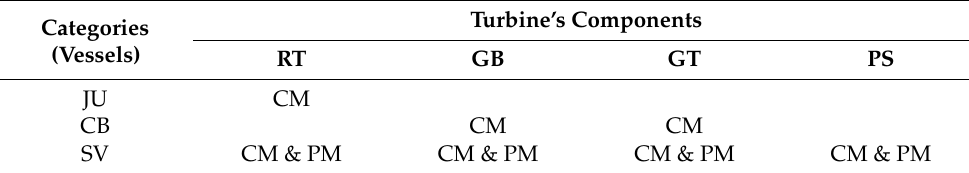
Table 3. Maintenance